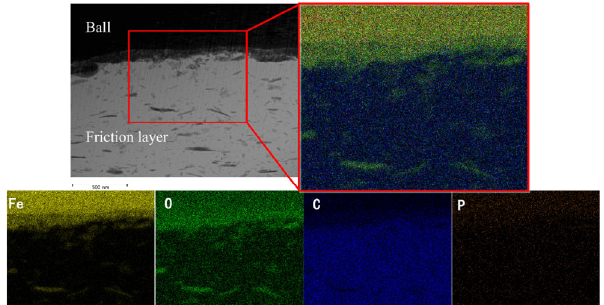
Fig. 22 The distribution of the chemical elements in frictional layer at worn surfaces of balls.